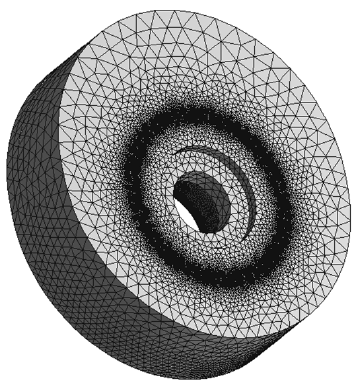
Figure 7. 3D fluid–solid coupled model of the end domain.